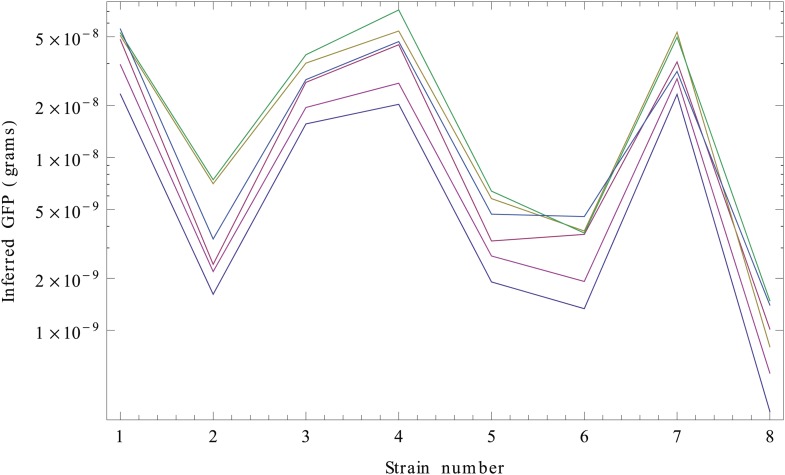
Inferred GFP amounts (in grams, vertical axis) for the eight strains (strain numbers shown along the horizontal axis) using the reference data from each replicate.Each color corresponds to a replicate. The vertical axis is shown on a logarithmic scale.